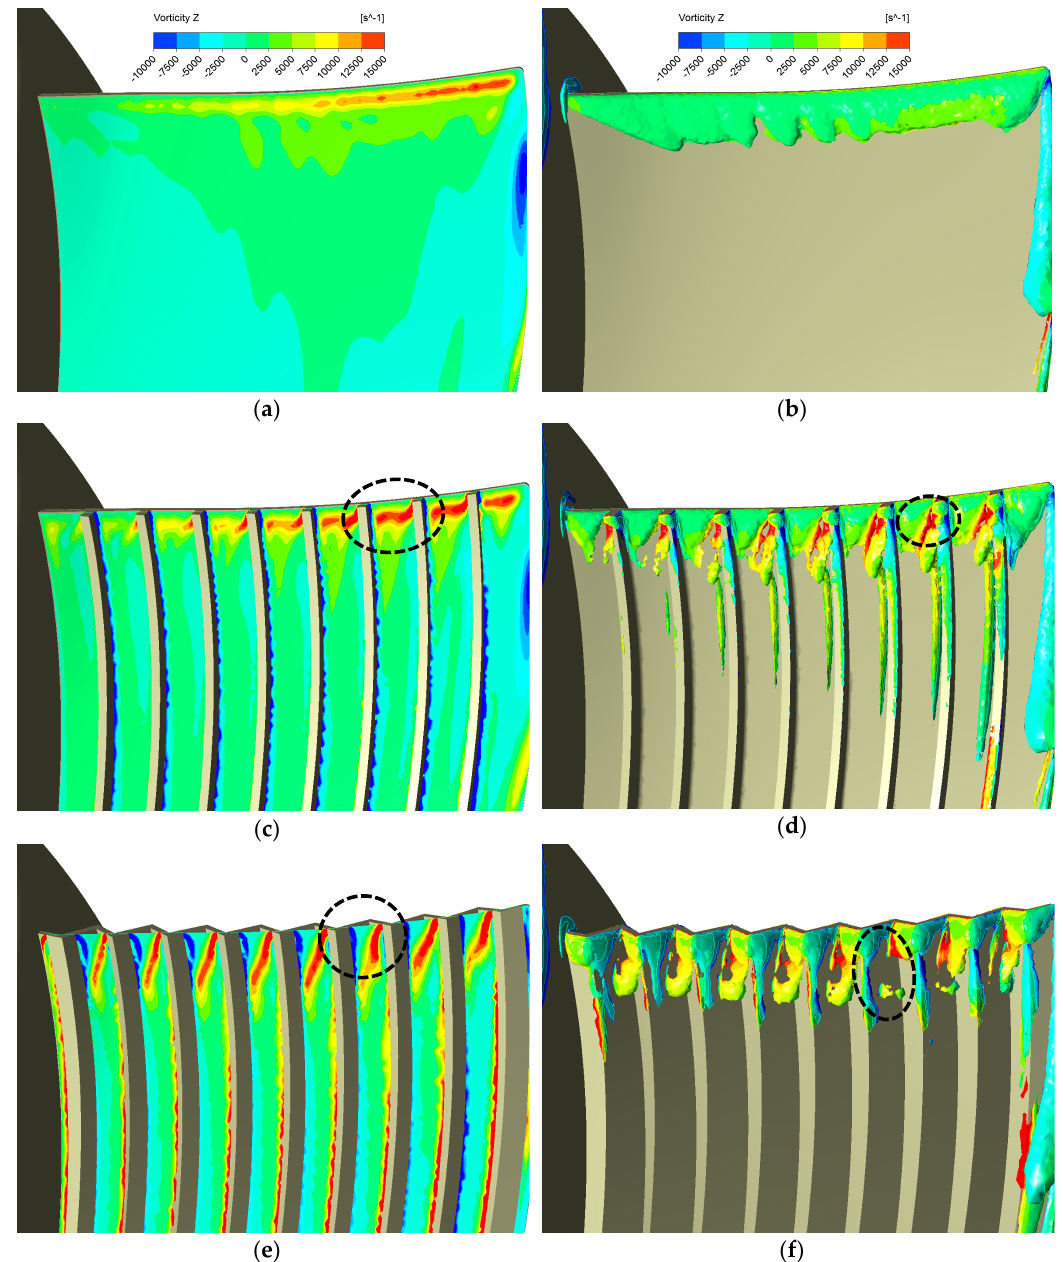
Figure 13. Axial vorticity on Off_Suc_1 mm and vortex core region (Q = 0.02): ( a ) and ( b ) Basic, ( c ) and ( d ) Rib N9 H4.2, ( e ) and ( f ) Wavy N9 H3. Regions in circles show obvious stronger axial vorticity than the basic.